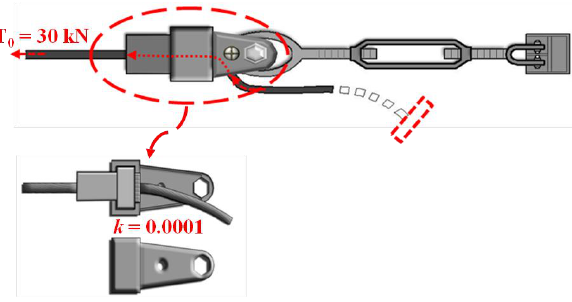
Figure 22. Schematic drawing for the physical impression of the potential Dhakal-LPR Brake 2 Fig. 22. Schematic drawing for the physical impression of the po- Model device. Note the stopper. 3 tential Dhakal-LPR Brake Model device. Note the